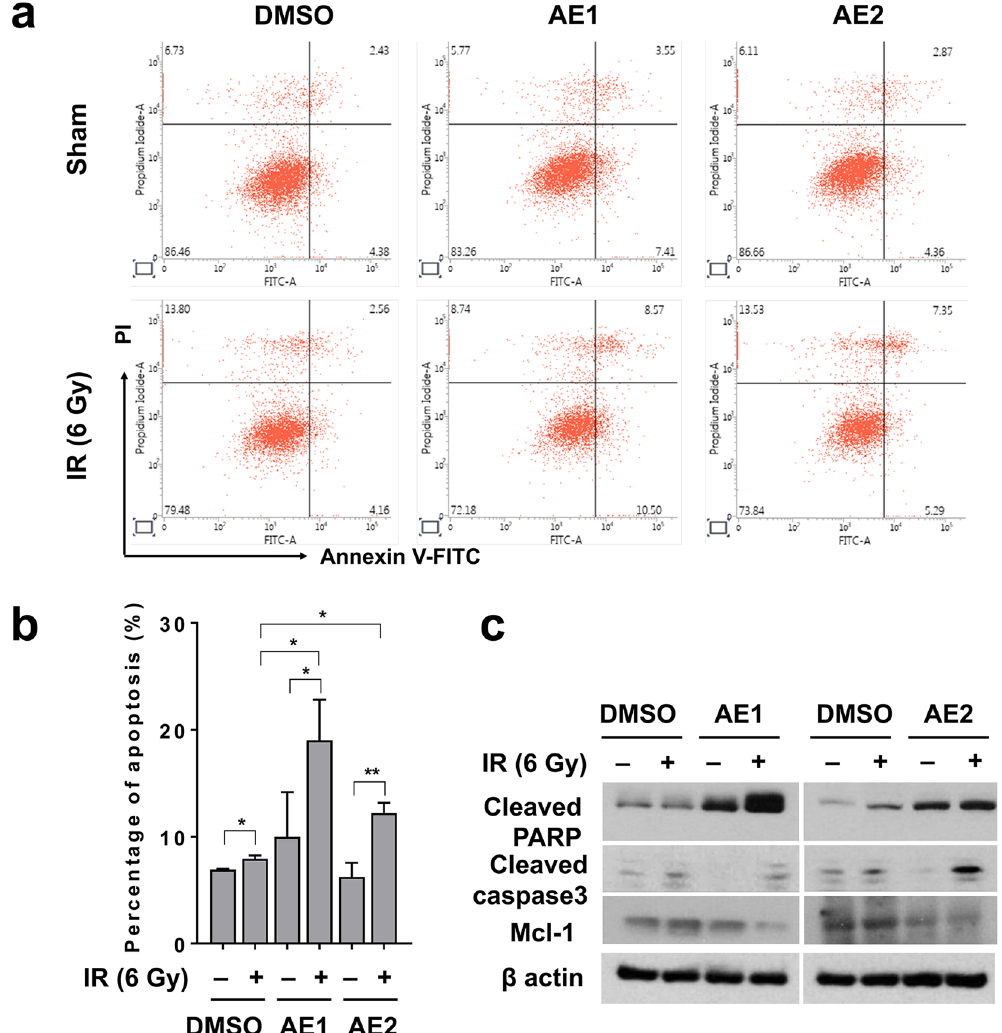
Figure 3. The Agelas extracts enhance IR-induced apoptosis. ( a ) Apoptosis was assessed by flow cytometry with FITC-conjugated annexin V/PI staining. Hep3B cells were pre-treated with 10 µ g/mL of AE1 or AE2 for 3 h, followed by exposure to 6 Gy of IR. After 24 h of incubation, Hep3B cells were co-stained with annexin V-FITC and PI and was subjected to flow cytometer. ( b ) Quantification of apoptotic cell percentage showed the Agelas extracts enhanced IR-induced apoptosis. The data represent the means ± SD of three independent experiments (n = 3; * p < 0.05, ** p < 0.01). (c) Western blot analysis confirmed enhanced apoptosis by the Agelas extracts. Hep3B cell lysates were immunoblotted for the detection of cleaved PARP1, and Mcl-1. β -actin was used as a loading control. Uncropped images are shown in Supplementary Fig.